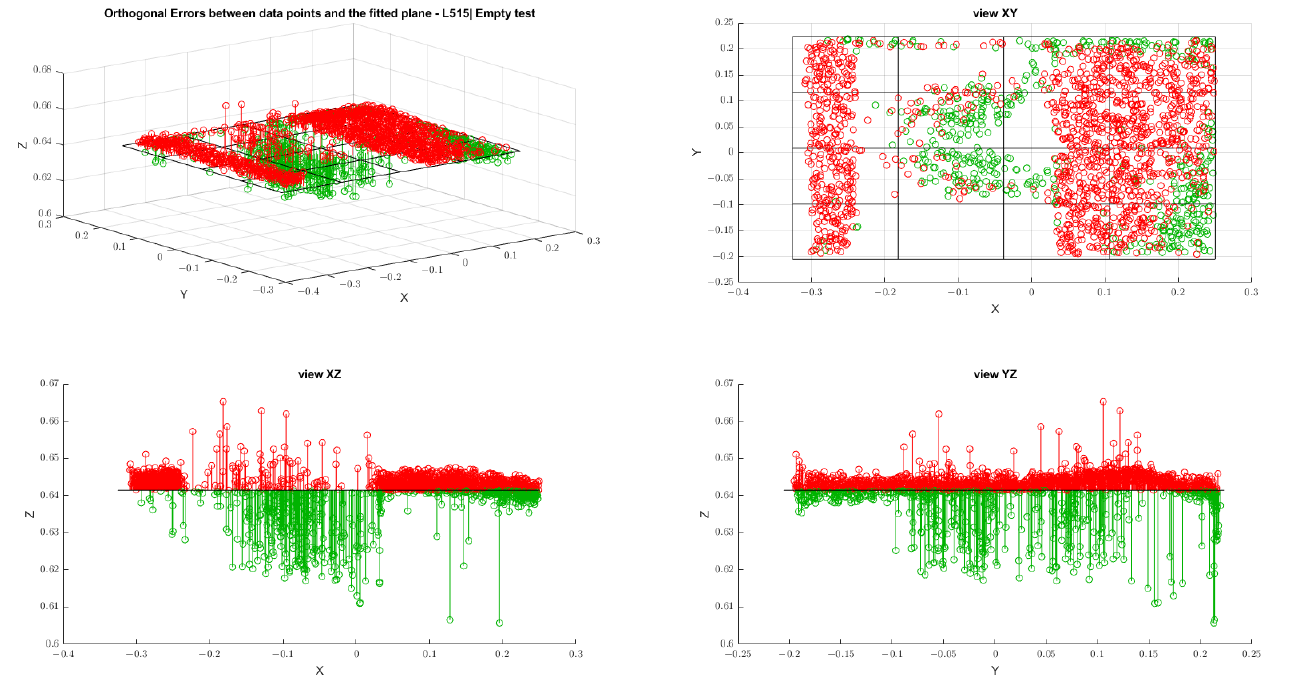
Figure A9. Results of orthogonal errors for the L515 camera referring to the empty test.